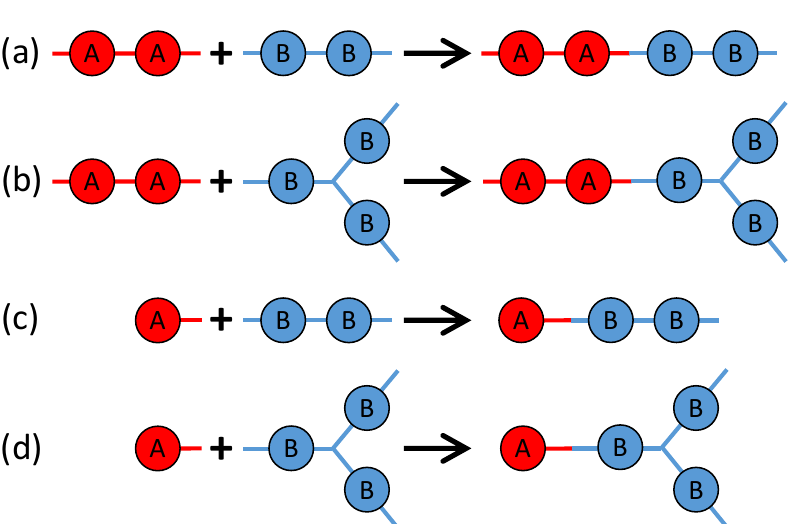
Figure 2. The four reactions occurring in the polymerization of the branched PEIs: ( a ) Reaction 1: BPADA + MPD, ( b ) Reaction 2: BPADA + TAPE, ( c ) Reaction 3: PA + MPD, and ( d ) Reaction 4: PA +